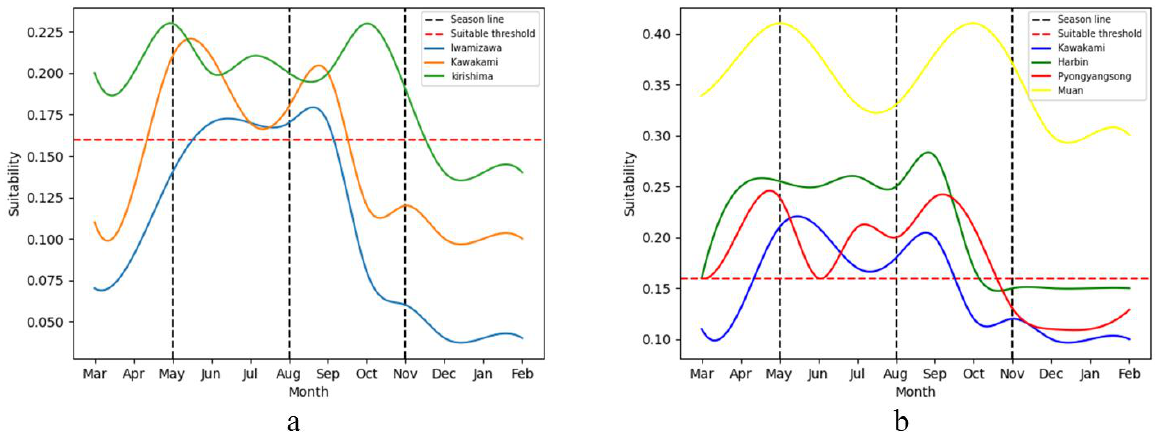
Figure 11. The responses of production to suitability: ( a ) Kawakami, ( b ) Minamimaki (2005 – 2016).